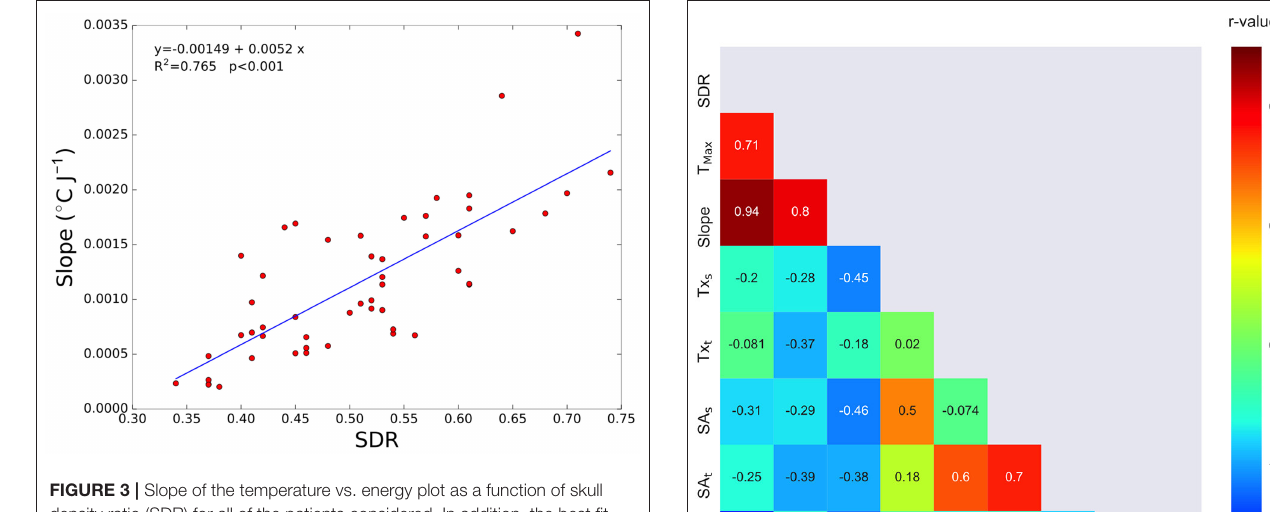
FIGURE 3 | Slope of the temperature vs. energy plot as a function of skull density ratio (SDR) for all of the patients considered. In addition, the best fit linear curve is shown (blue line). Each marker (red circles) represents a patient.